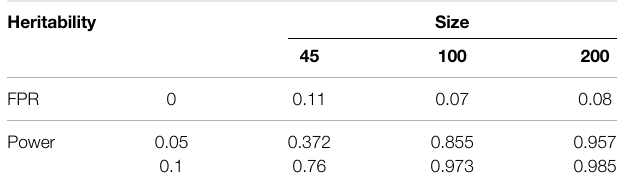
TABLE 2 | The positioning accuracy and false positive probability of signi fi cant QTLsidenti fi edbyDDHR.Theexperimentssimulatedtheco-culturing45pairs (the same as the real example), 100, pairs and 200 pairs under heritability levels of 0, 0.05 and 0.10. The positioning accuracy and false positive probability were evaluated by computer